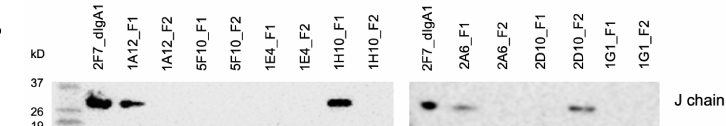
Figure 4. Analysis of the human hybridoma IgA mAbs after Jacalin purification. ( A ) Gel filtration with a Superose 6 HR 10 / 300 column. Protein peaks for all samples were collected in the two fractions shown (F1, ~27 min; F2, ~33 min). 8C5 IgG and 1G1 IgG are used as monomer controls. ( B ) Western blot analysis of the F1 and F2 fractions for expression of the Ig J chain. Recombinant 2F7 dIgA1 (Section 3.6) was used as a positive control. Molecular weight markers (in kD) are indicated on the left.